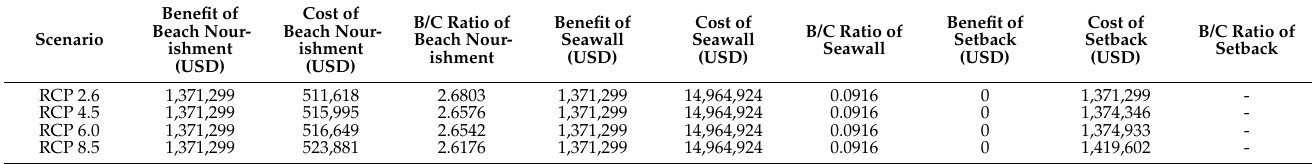
Table 12. Benefit–cost ratio analysis of Chalatat